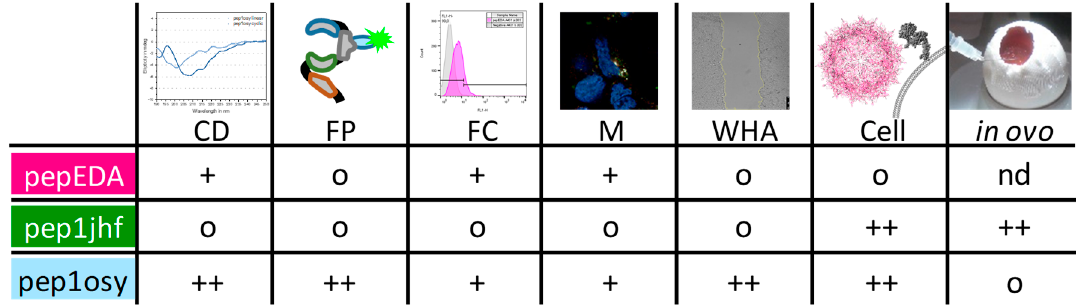
Figure6. Summaryofpeptidepropertiesdeterminedusingcirculardichroism(CD),fluorescencepolarization Figure 6. Summary of peptide properties determined using circular dichroism (CD), fluorescence (FP), flow cytometry (FC), microscopy (M), wound healing assay (WHA), and transduction experiments in polarization (FP), flow cytometry (FC), microscopy (M), wound healing assay (WHA), and cell culture (Cell) and in CAM assays (in ovo). Peptides were ranked regarding their performance in transduction experiments in cell culture (Cell) and in CAM assays (in ovo). Peptides were ranked each experiment from o (neutral / negative), + (good), and ++ (very regarding their performance in each experiment from o (neutral/negative), + (good), and ++ (very good).